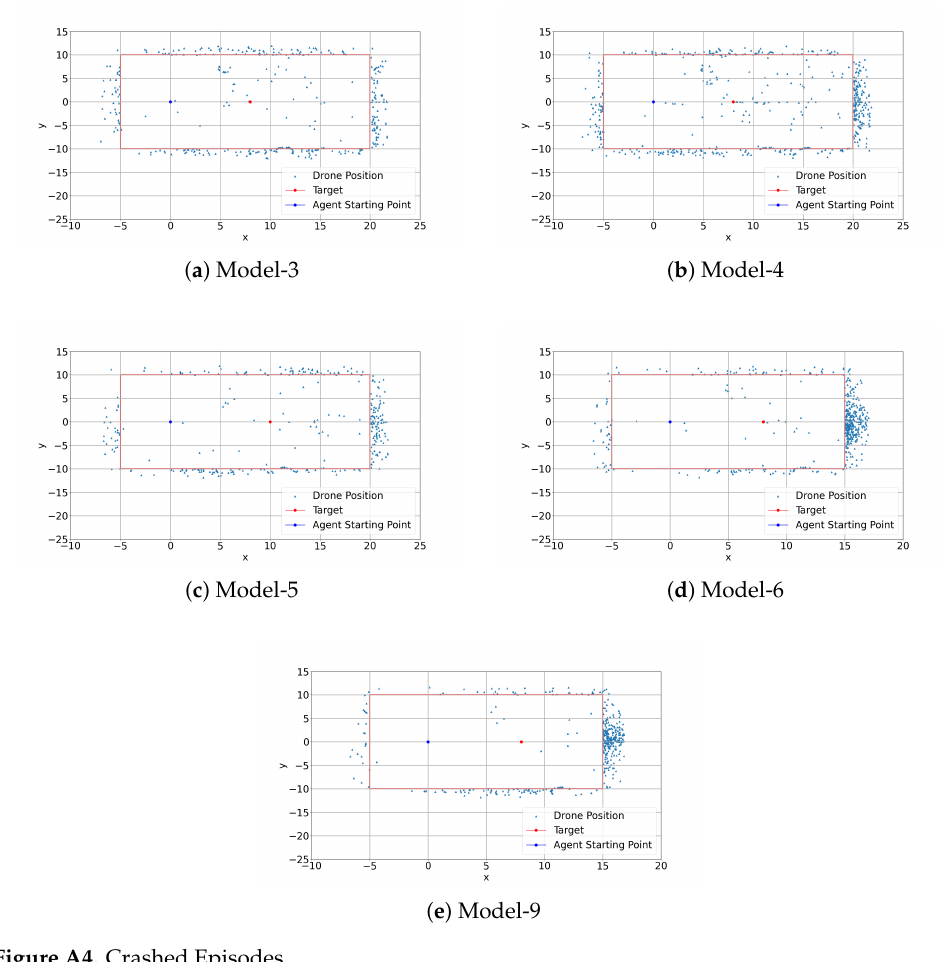
Figure A4. Crashed